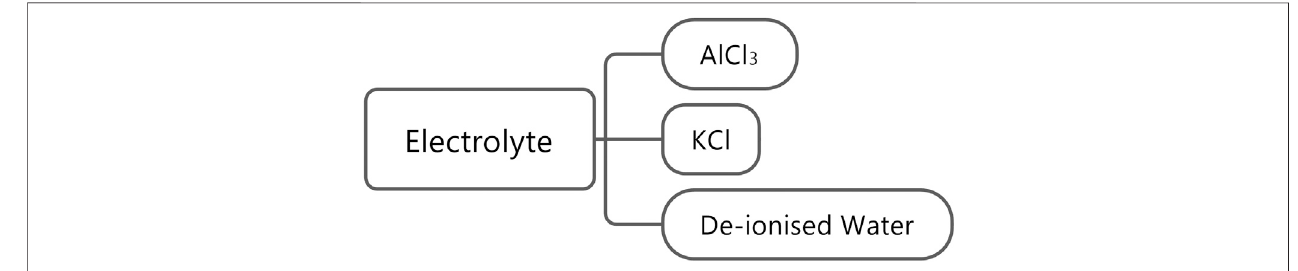
FIGURE 6 | Production fl ow for the electrolyte redrawn from